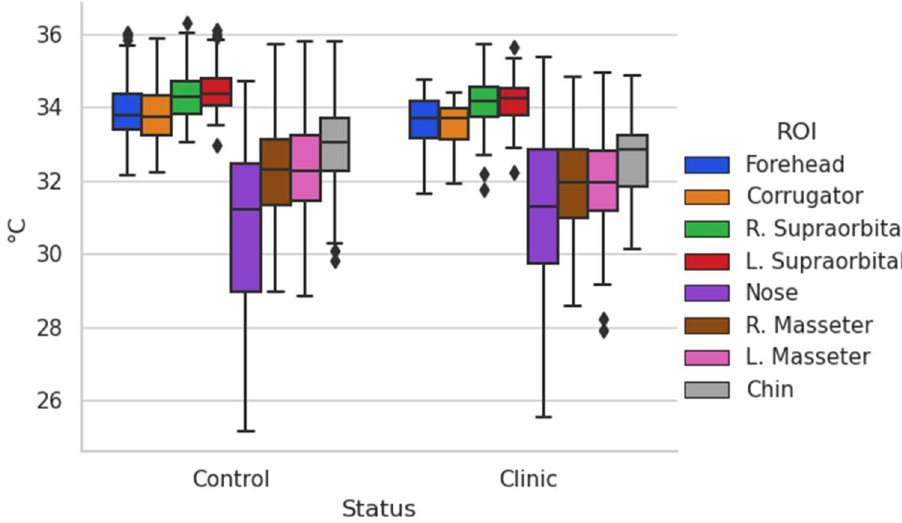
Figure 6. Box-and-whisker chart comparison by Figure 8. Box-and-whisker chart Control and Clinic group.